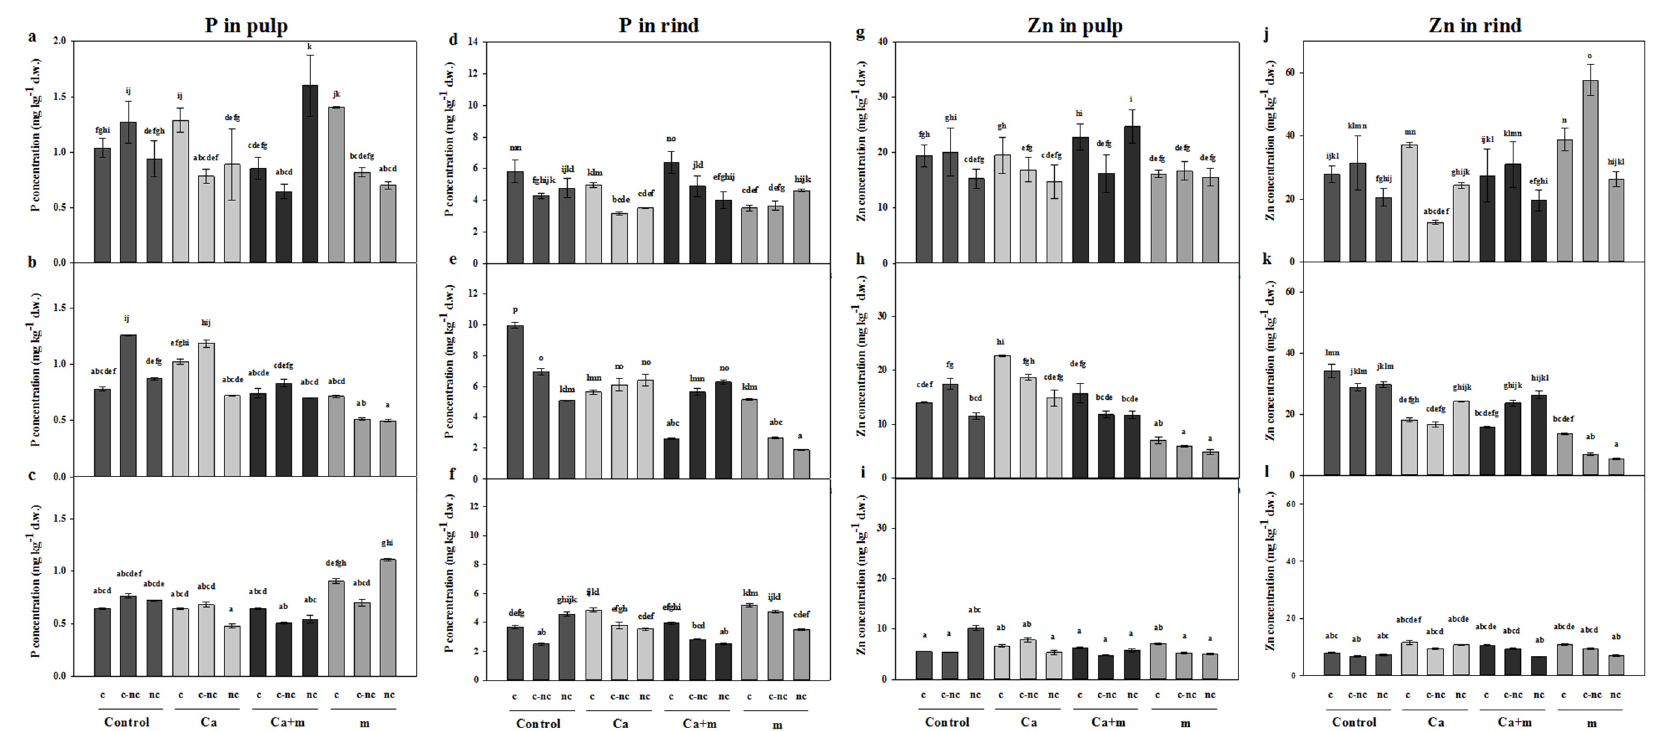
Figure 7. The P concentration (dry weight basis) in pulp, ( a ) control irrigation, ( b ) conductivity irrigation, and ( c ) double irrigation, and rind, ( d ) control irrigation, ( e ) conductivity irrigation, and ( f ) double irrigation. The Zn concentration (dry weight basis) in pulp, ( g ) control irrigation, ( h ) conductivity irrigation, and ( i ) double irrigation, and rind, ( j ) control irrigation, ( k ) conductivity irrigation, and ( l ) double irrigation. The Ca treatment consisted of 8 mM CaCl 2 and 2 mM CaSO 4 , the Ca + m treatment consisted of a commercial mixture (Antisal gold, Nufol ® ) (Table 1), and the m treatment consisted of another commercial mixture (Microfold, Nufol ® ). Codes: c, cracked region in cracked fruit. c-nc, non-cracked region in cracked fruit. nc, non-cracked fruit. Statistical analysis was performed using SPSS 25.0.0.1. and included all the irrigation treatments, separating each element and each type of tissue. The values are the means ± SE of three individual analyses. Columns with different letters differ significantly according to Duncan’s test ( p = 0.05).